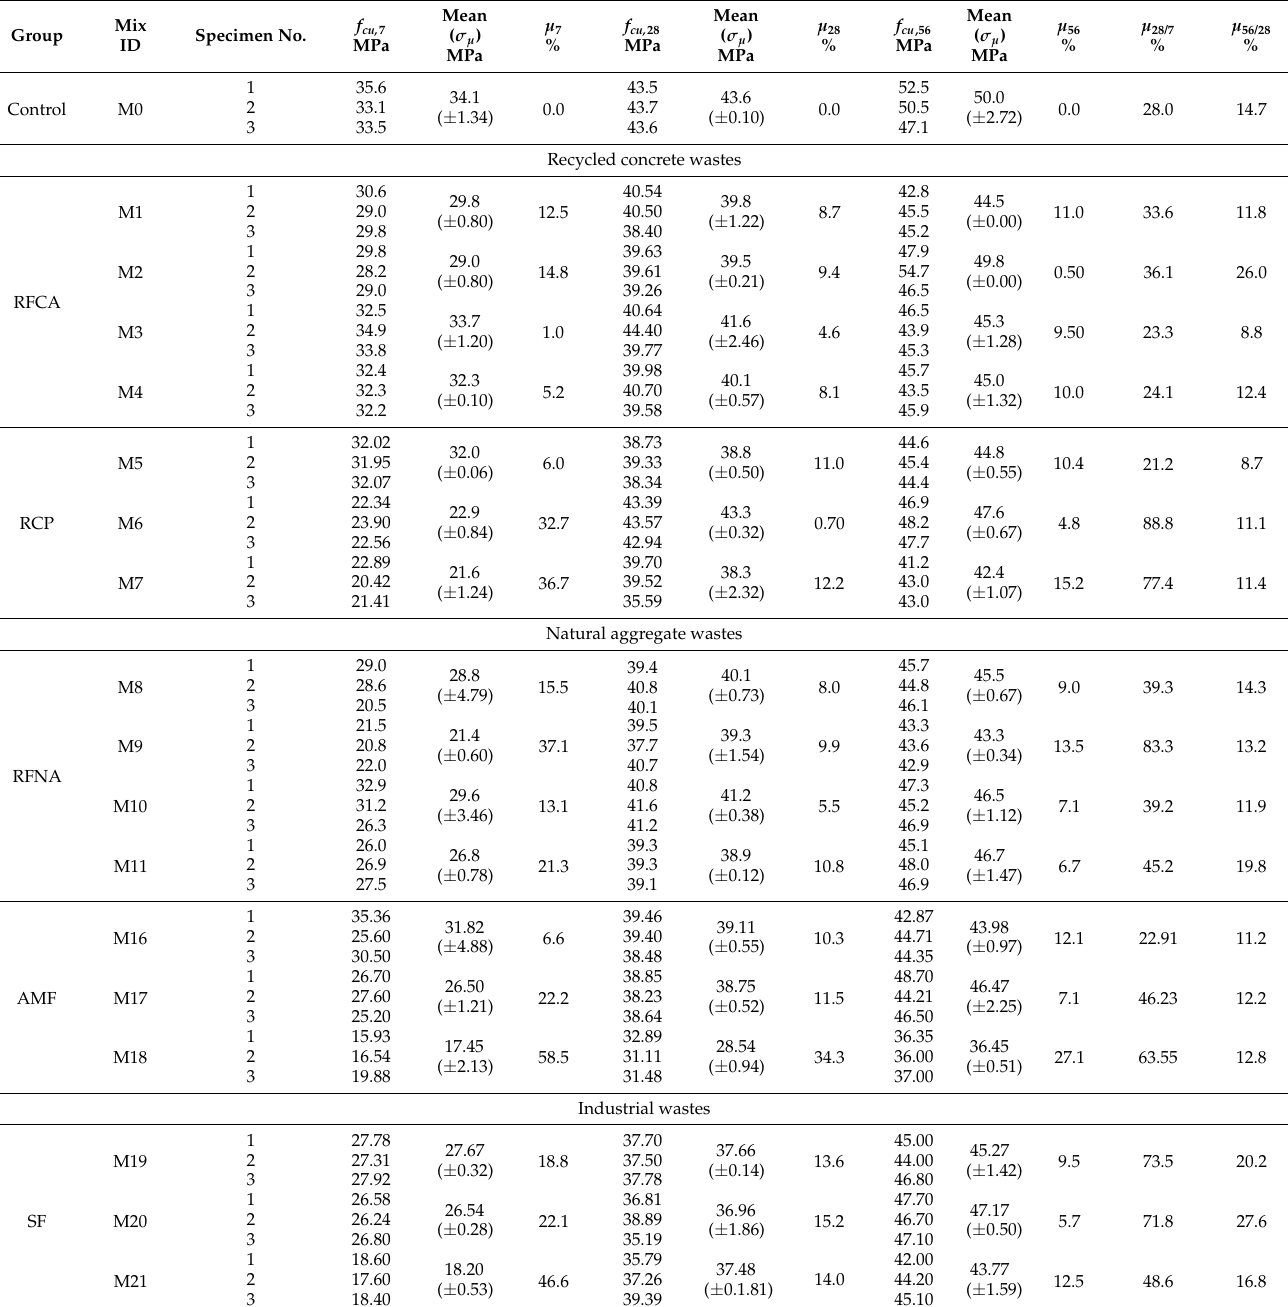
Table 4. The concrete compressive strengths for all mixes at 7, 28, and 56